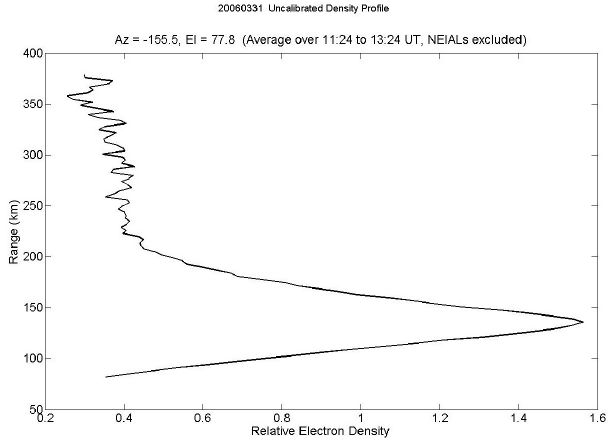
Fig. 9. The uncalibrated, relative electron density versus altitude for the 2h period during the NEIAL events of 31 March 2006. This is an average over the period from 11:24UT to 13:24UT with the NEIALs